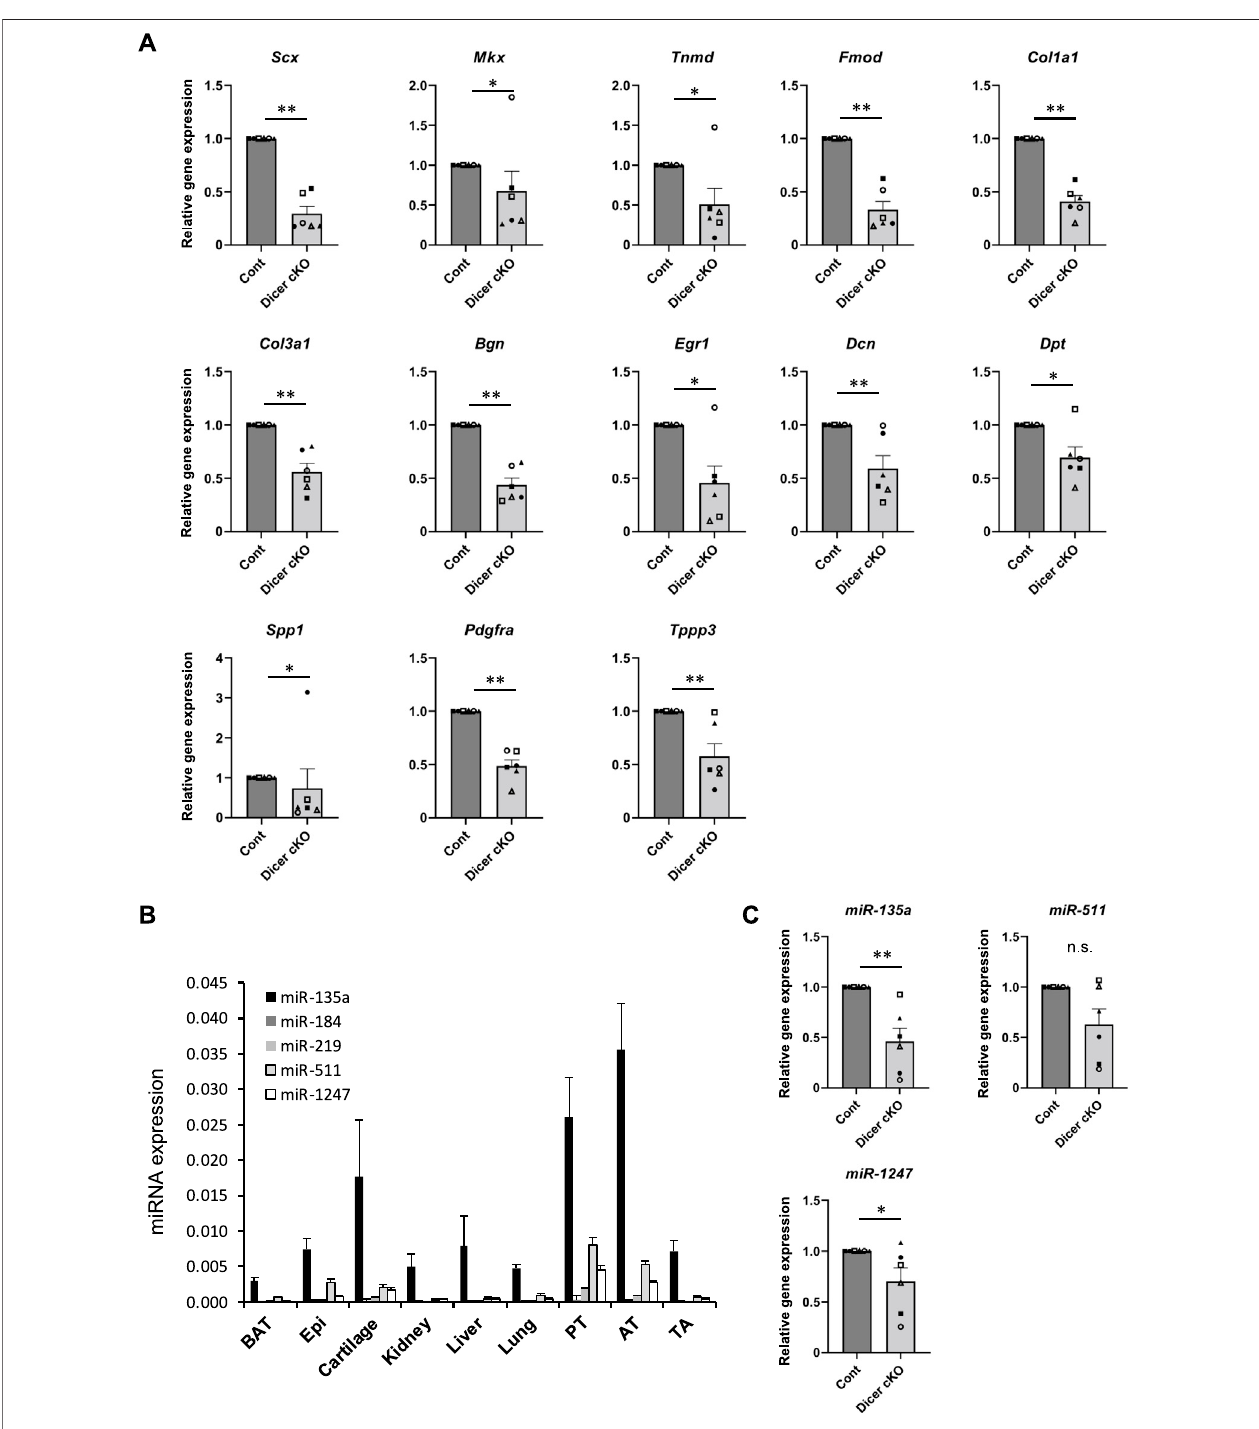
FIGURE 6 | Tendon related-genes and -miRNAs expression in Achilles tendon tissues of Dicer cKO mice. (A) The expression of tendon-related genes in Achilles tendon tissues from Cont and Dicer cKO mice ( n = 6 each group) at 4 weeks of age. (B) The expression of selected miRNAs in various tissues from C57BL6/J mice ( n =4). (C) Theexpressionoftendon-related miRNAs inAchillestendon tissues fromContand Dicer cKOmice ( n =6miceforeach genotype) at4 weeksofage.Alldata represented as mean ± SEM. Comparison of genes or micro RNAs expression was performed using Mann-Whitney U test; * p < 0.05, and ** p < 0.01 versus Cont. n.s.: no signi fi cant difference.